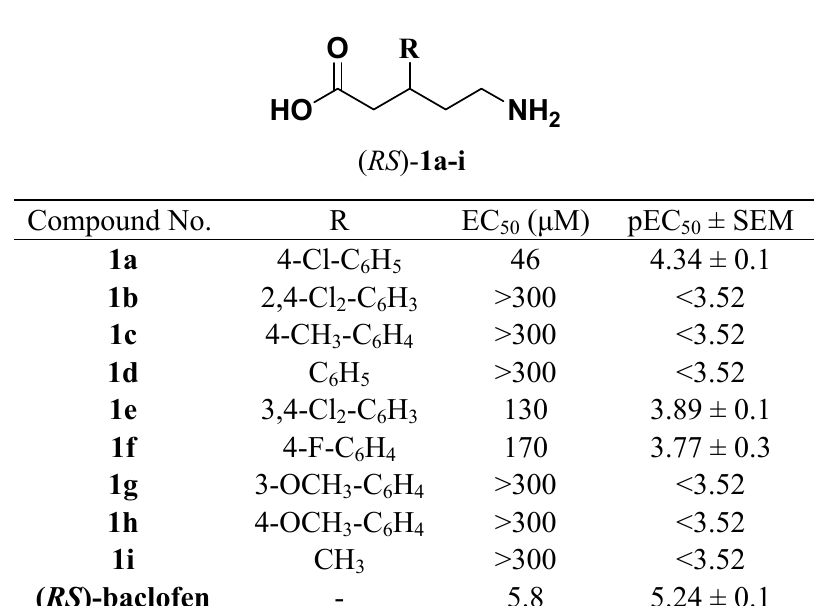
Table 1. GABA agonistic activity of the target compounds 1a – i . B